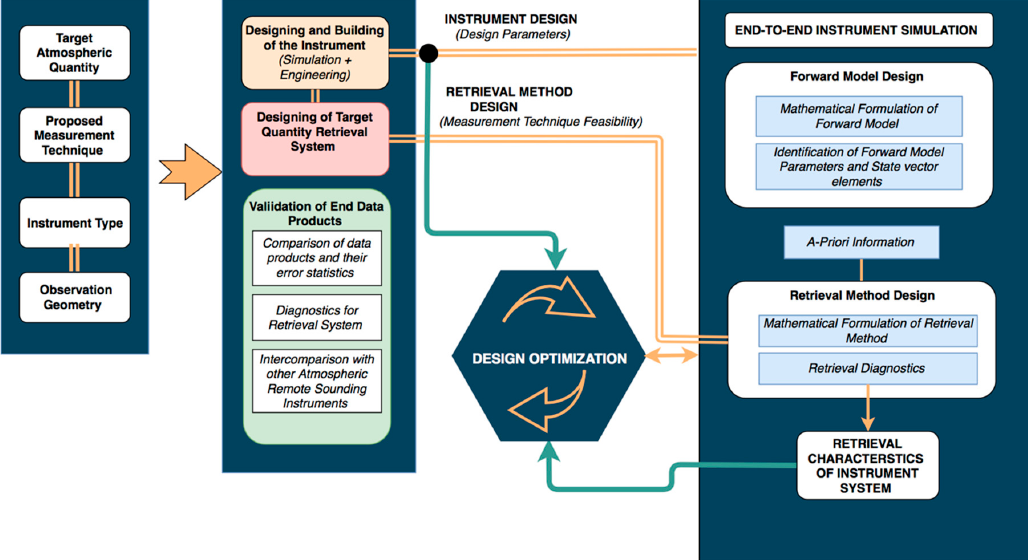
Figure 2. A flow-diagram for the visualisation of the process of design and optimisation of a satellite atmospheric observing system via end-to-end simulation.